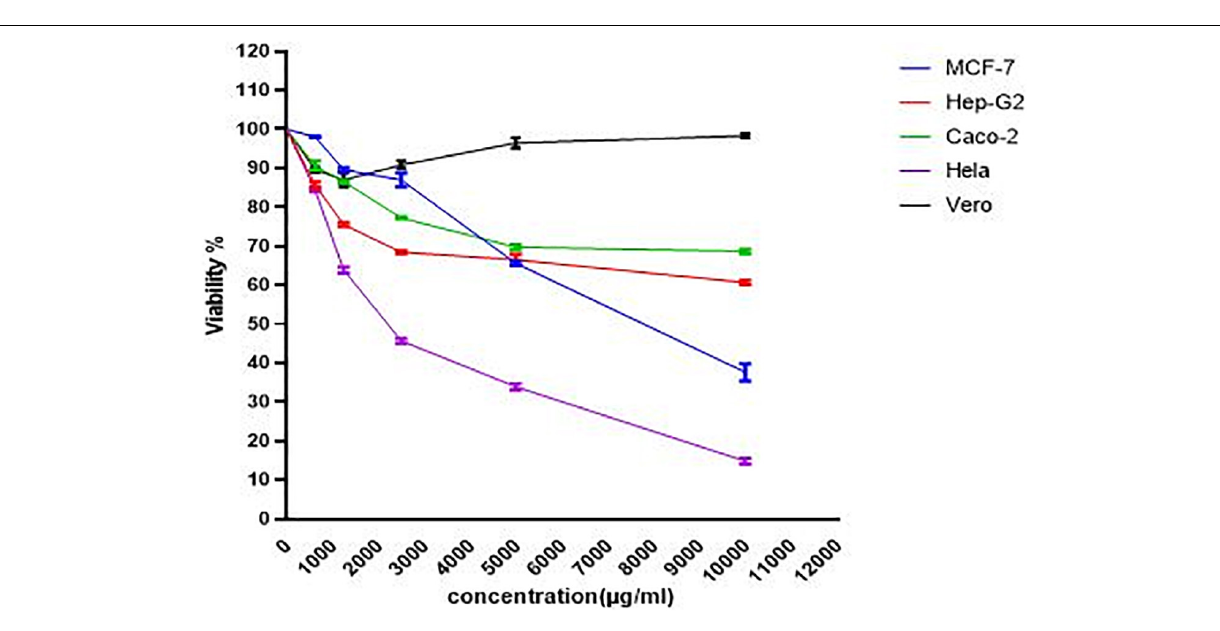
Frontiers in Microbiology |